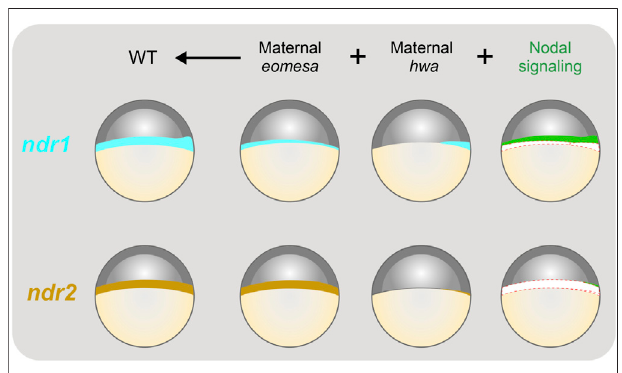
FIGURE 8 | Illustration of contributions of maternal eomesa , hwa / β - catenin signaling and Nodal signaling to ndr1 and ndr2 expression. The expression pattern of ndr1 and ndr2 in the late blastula (in lateral view with dorsal to the right and animal pole to the top) is depicted. The overall expression level of ndr1 or ndr2 is the sum of contributions from maternal eomesa (as seen in M hwa without Nodal signaling), maternal hwa / β -catenin signaling (as seen in M eomesa without Nodal signaling) in and Nodal signaling (autoregulation). In wildtype (WT) embryos, all of the three forces make a signi fi cantcontributionto ndr1 expression; however,maternal eomesa makes a predominant contribution to ndr2 expression while maternal hwa / β -catenin signaling may contribute a little to ndr2 expression by activating ndr1 in the dorsal blastodermal margin and thereof Nodal signaling. In the last column, ndr1 and ndr2 levelscontributedby eomesa and hwa wereshownasemptyto highlight the contribution of Nodal